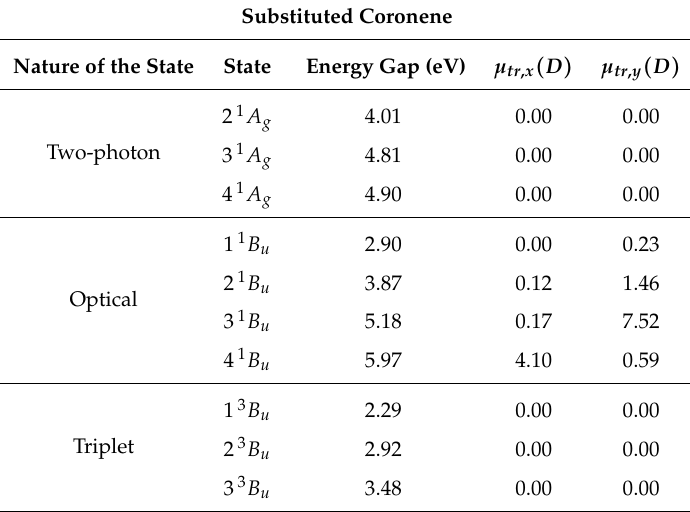
Energies of the low-lying states states in substituted coronene are tabulated below. The transition dipole moment (in Debye) from the ground state to the excited states ( µ tr , x / y ) along specific axes is also specified in the last two